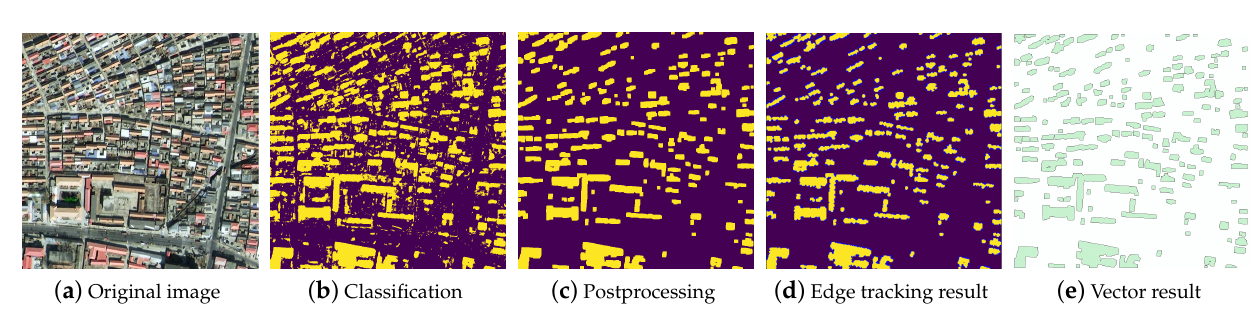
Figure 2. This group of images represents the process diagram of the vector pre-extracted by a simple machine learning algo- rithm, and their respective meanings are expressed as follows: ( a ) original image, ( b ) classification result, ( c ) postprocessing result, ( d ) building edge tracking result, and ( e ) vector result.